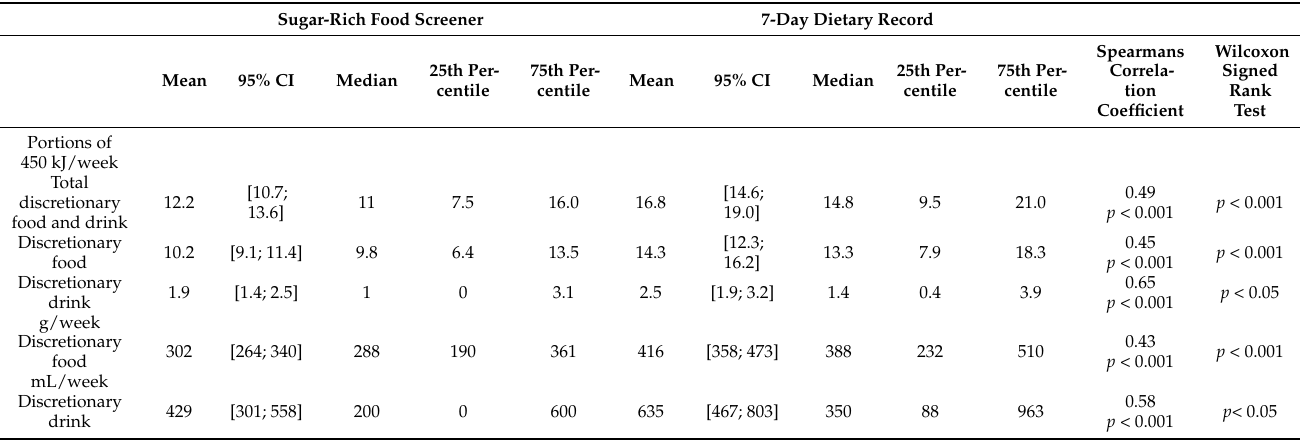
Table 2. Summary of intake of discretionary foods and drinks estimated by the SRFS and the 7-day dietary record in amount in portions of 450 kJ, g, or mL per week ( n = 80).